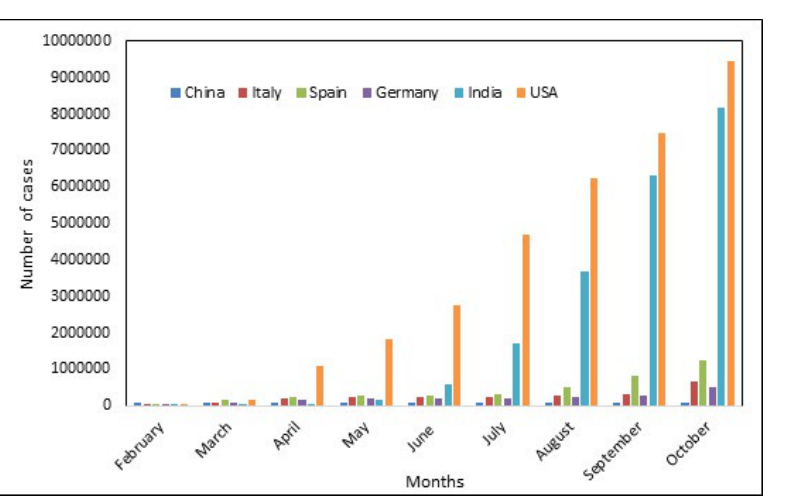
Fig. 3. Number confirmed cases in China, Italy, Spain, Germany, USA and India; as of Oct 2020. (WHO-Novel coronavirus (2019-nCoV). Situation